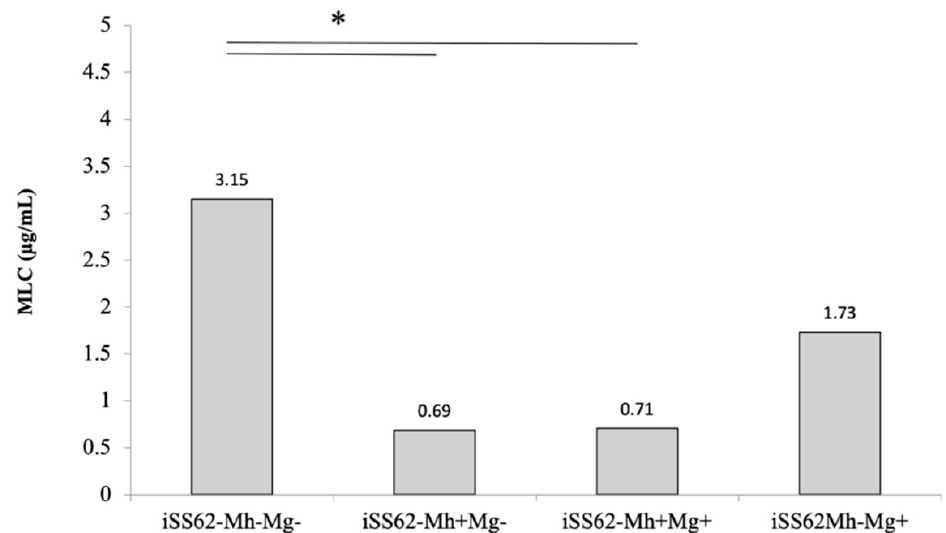
Figure 2. The metronidazole susceptibility of T. vaginalis isogenic strains. The mean values of metronidazole MLC for T. vaginalis experimentally (iSS62-Mh + Mg − , iSS62-Mh + Mg + ) and naturally Mycoplasma -infected (iSS62-Mh − Mg + ), and for Mycoplasma -free T. vaginalis (iSS62-Mh − Mg − ), were compared. The presence of M. hominis in trichomonad cells is associated with an increase of sensitivity to metronidazole compared to iTv, independently from the presence of Mg (* p < 0.05). Statistical significance was tested by Student’s t -test.